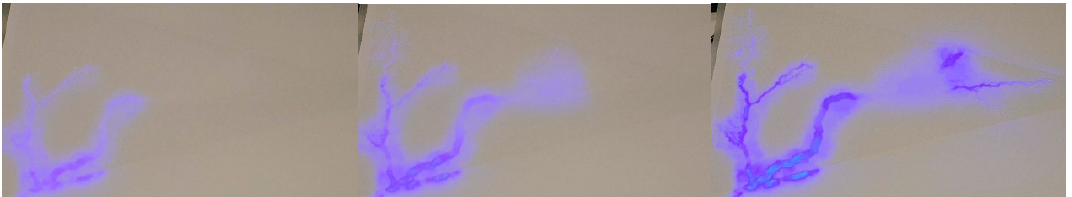
Figure 5. Prototype lightening flash with paper diffuser.